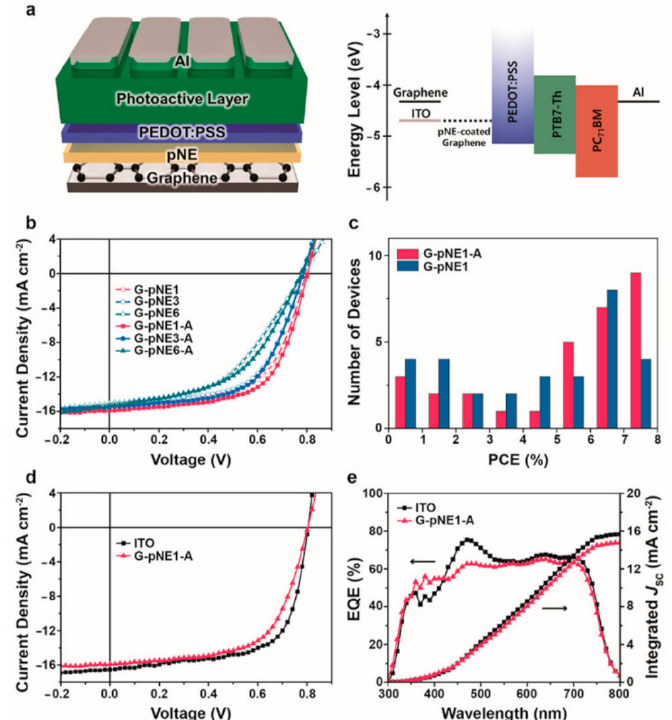
Figure 19. Device performance of the pNE-coated graphene-based OSCs. ( a ) Schematic of the conventional device and the corresponding flat-band energy-level diagram. ( b ) J − V characteristics of the pNE-coated graphene-based OSCs with and without the annealing treatment. ( c ) Performance statistics for the OSCs with and without annealing. ( d ) J − V characteristics and ( e ) EQE measurements with corresponding integrated Jsc of the device with the best performance (G-pNE1-A) compared with those of the ITO reference. Reproduced from [121] with the permission of the American Chemical